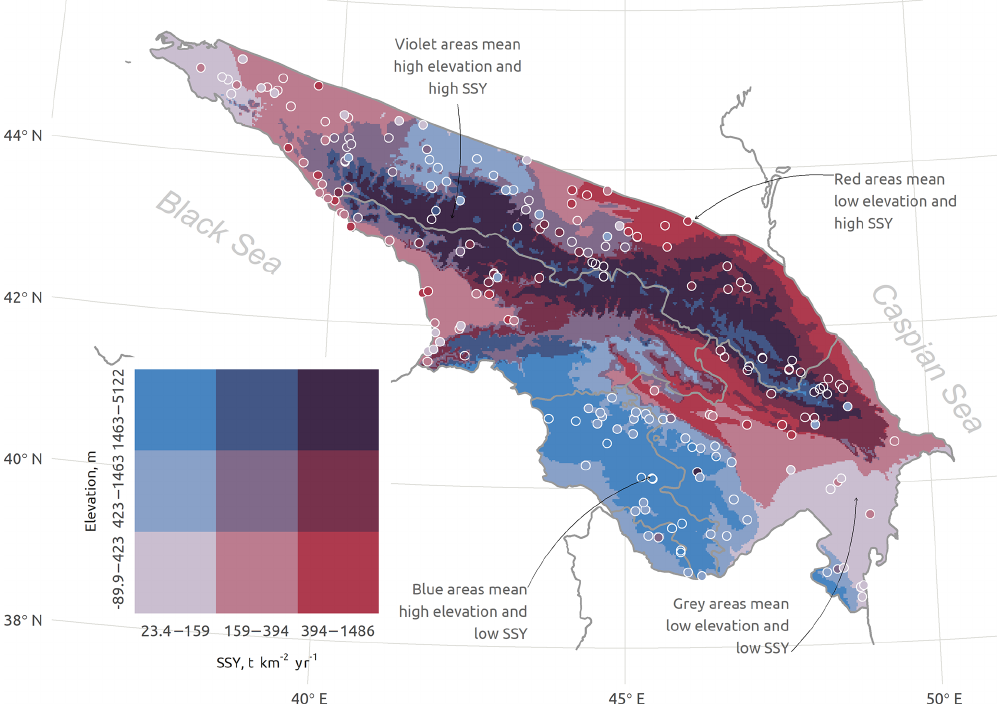
Figure 3. Elevation ( H , ma.s.l.) and average annual Suspended Sediment Yields ( SSY , tkm − 2 yr − 1 ) as estimated based on our SSY database.